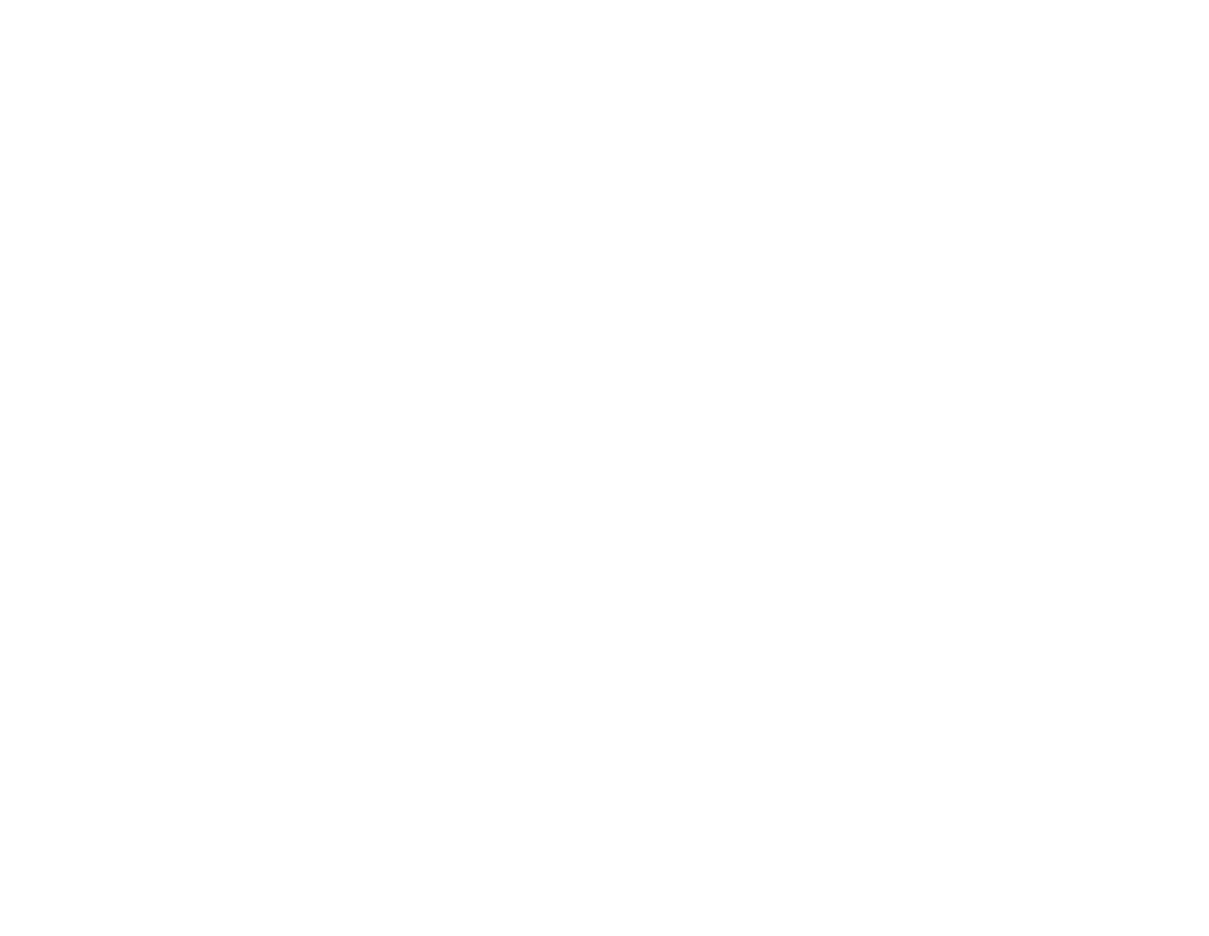
FIGUREA4 |The same relationship between ventral striatal activity and behavior that was observed in the ventral putamen also emerged in the nucleus accumbens (NAcc). Individuals with higher levels of signal change in